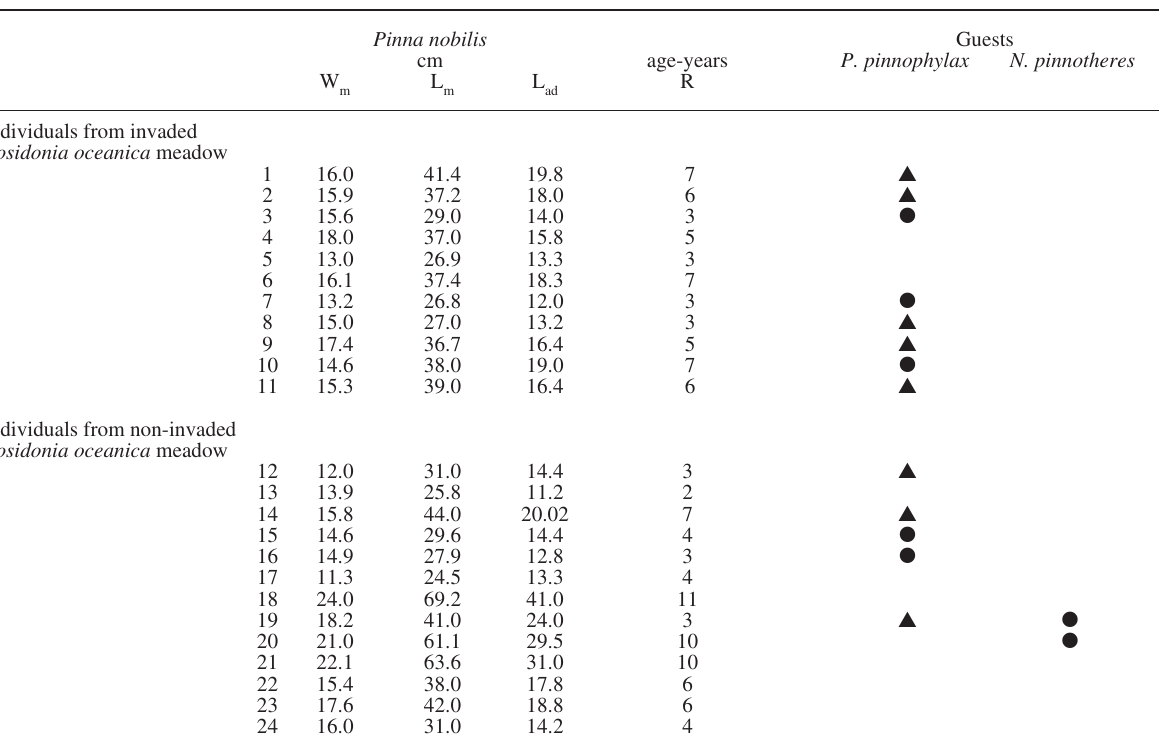
Table 1. – Morphometric features of Pinna nobilis specimens and the presence of its associated guests, the shrimp Pontonia pinnophylax and the pea crab Nepinnotheres pinnotheres . Maximum shell width (W ), maximum shell length (l ), maximum length of the posterior adductor m m muscle scars (l ), and number of muscle scar ring (R) are represented.  indicates the presence of guests of only one sex. p indicates the ad presence of the couple guests (male and female simultaneously). Pinna nobilis guests